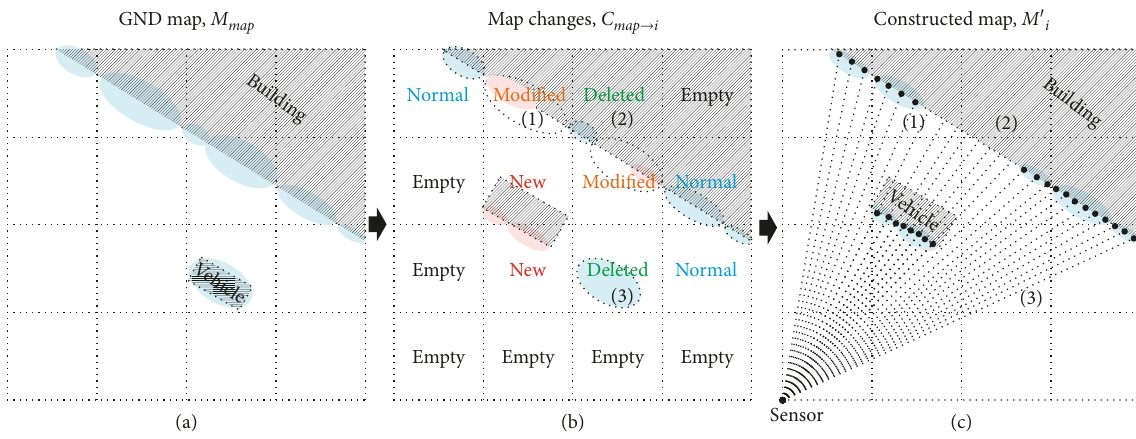
Figure 4: V2V comparison-based map change detection compared with map constructed by intelligent vehicles.